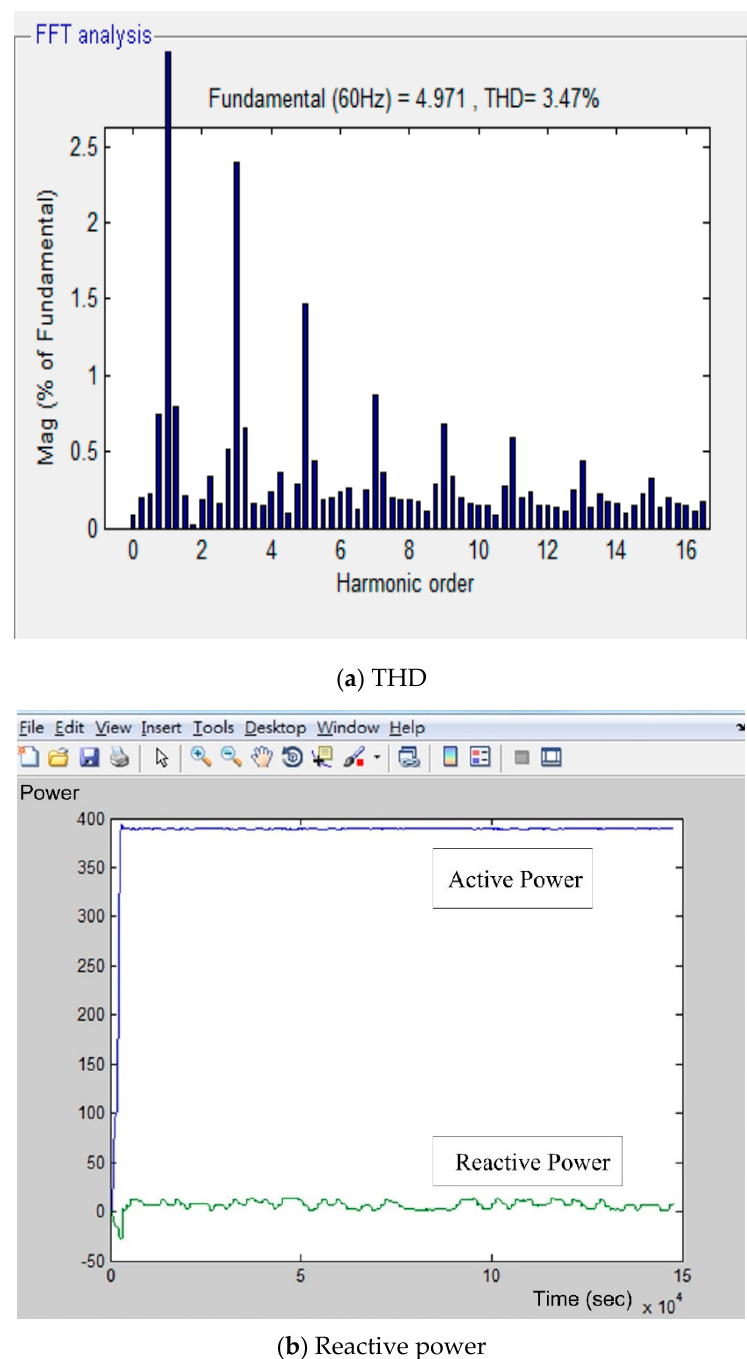
Figure 4. Analyzed data and waveforms for the initial design of the single-phase full-bridge vehicle-to-grid connected system.